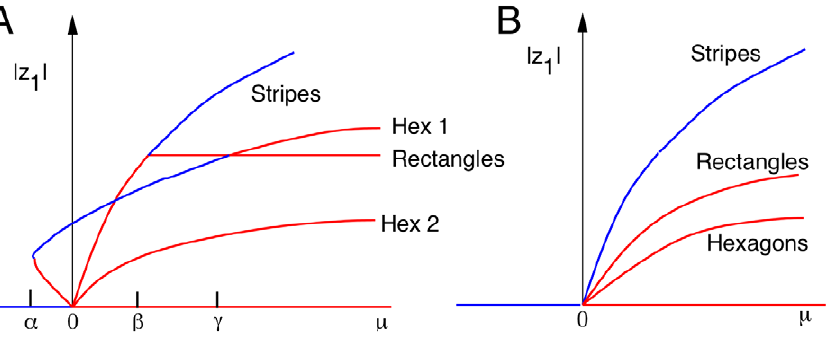
Figure 10. Schematic bifurcation diagram for patterns on a hexagonal lattice. (A) Bifurcation at low frequencies in equation (8) for the case where c w b w 0 and a = 0 (after [32], figure 5.8). a ~{ a 2 = (4( b z 2 c )) , b ~ a 2 b = ( b { c ) 2 and c ~ a 2 (2 b z c ) = ( b { c ) 2 : Blue curves represent stable solutions and red curves represent unstable solutions. The bifurcation parameter m is along the x { axis and the magnitude of the component of vertical stripe pattern ( D z 1 D ) is along the y -axis. (B) Diagram for high frequency patterns where a ~ 0 by symmetry. Because c w b , only stripes of various orientations are stable.